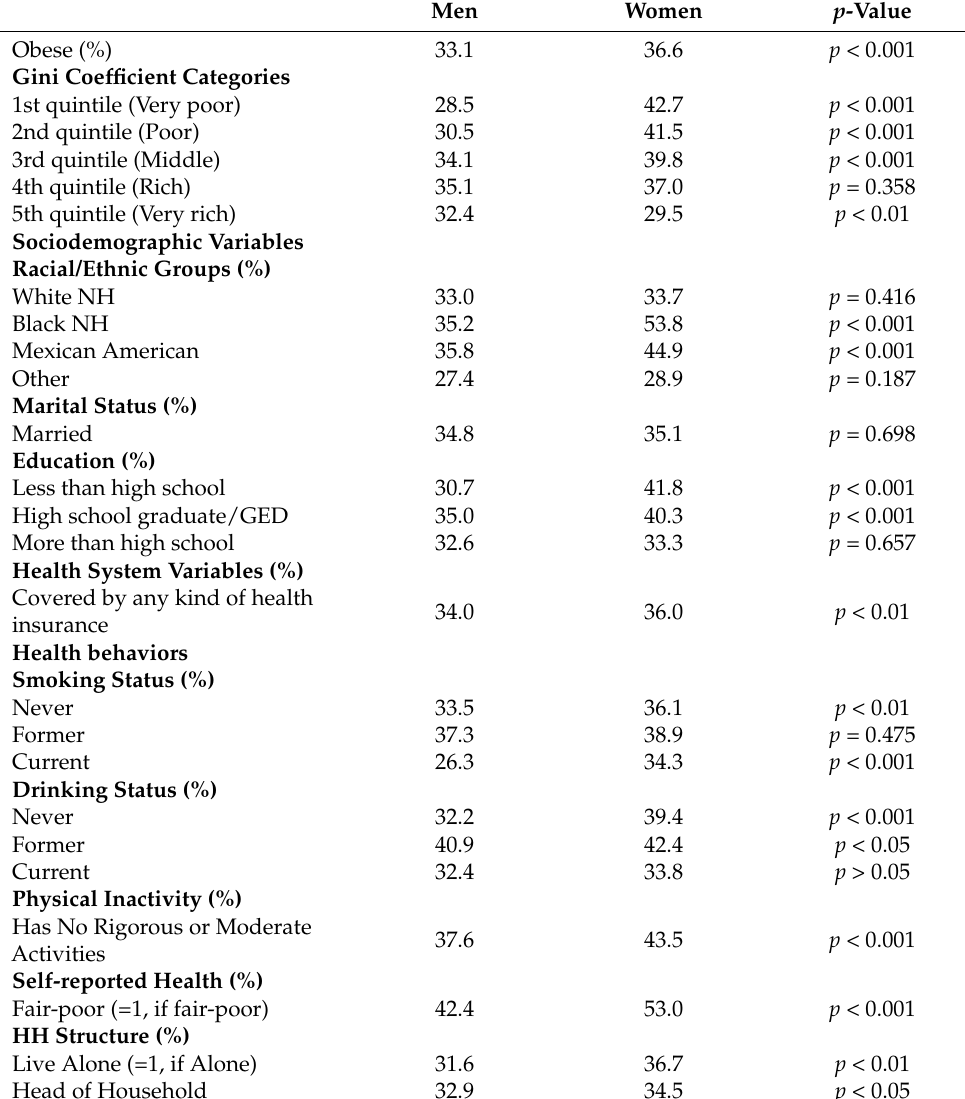
Table A1. Comparing Obesity Prevalence between Men and Women in US Adults over 20 years of age in 1999–2016 National Health and Nutrition Examination Survey (N =